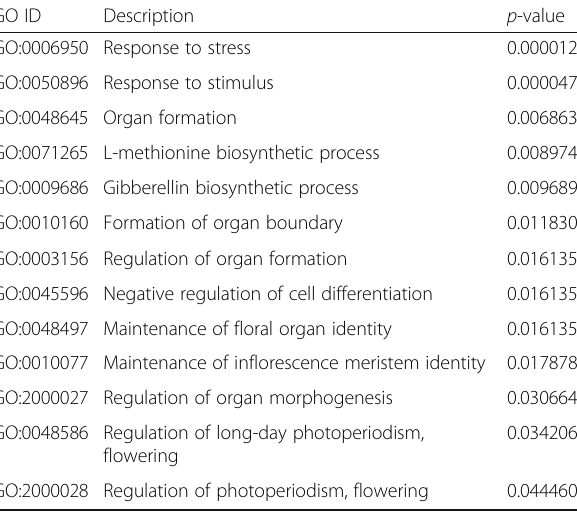
Table 5 Significant GO Terms of DG HP Between BS and YS in the Biological Process